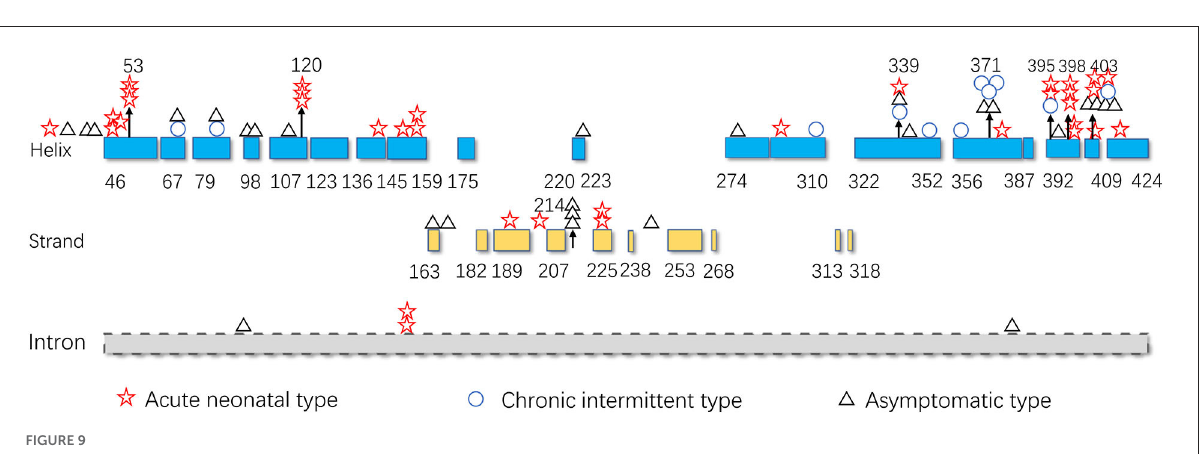
FIGURE9 The IVD variant distribution in Chinese patients with